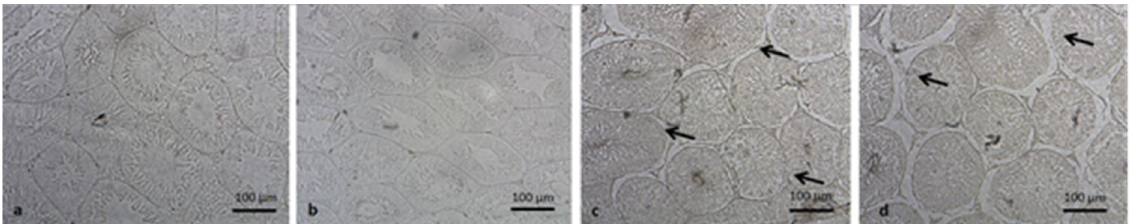
Figure 1. Demonstrative examples of TUNEL staining in Seminiferous tubules of each group. a: control; b: sham; c: ET/D (early torsion/detorsion group); d: LT/D (late torsion/detorsion group).